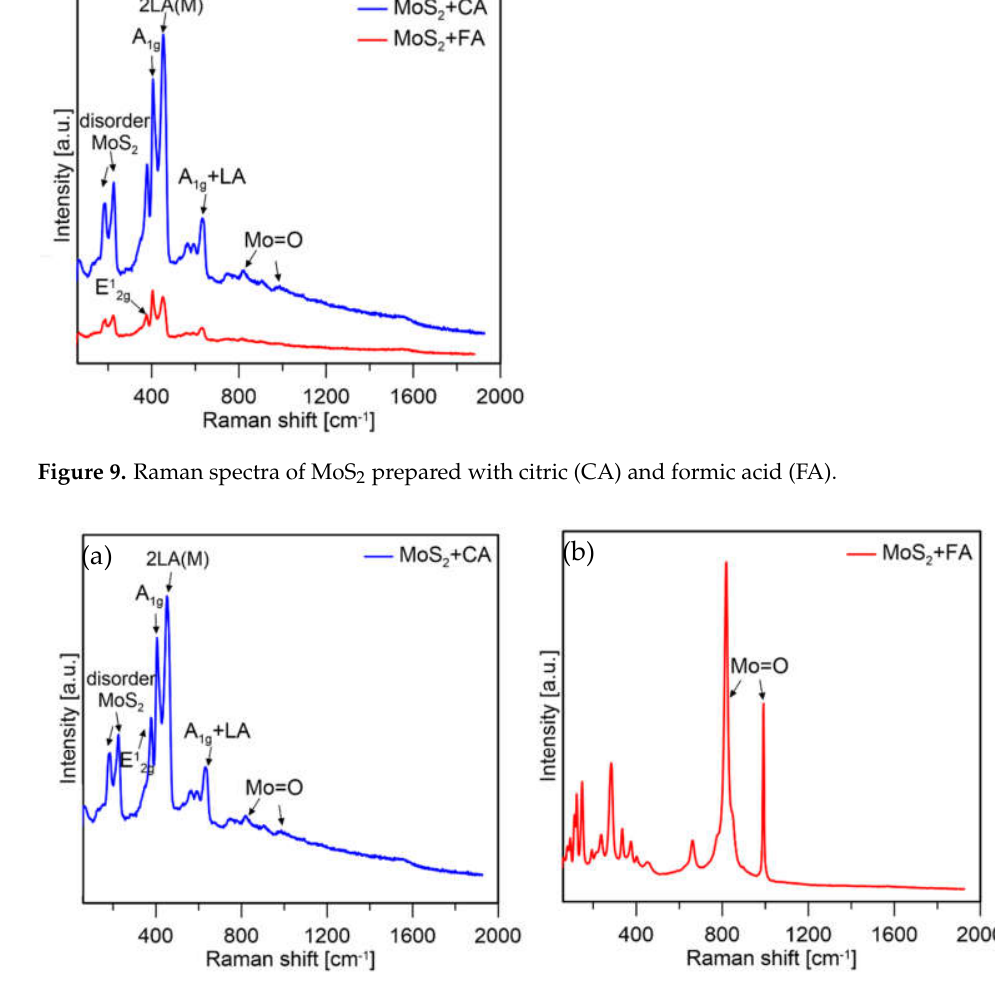
Appl. Sci. 2022 , 12 , 11293 Figure 10. Raman spectra of MoS 2 prepared with ( a ) CA and ( b ) FA at 5% laser power.